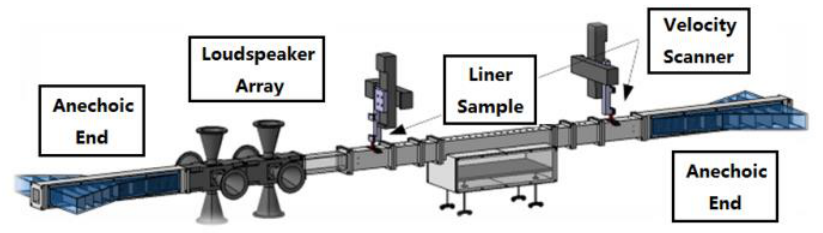
Figure 3. Schematic of impedance flow duct experimental platform.